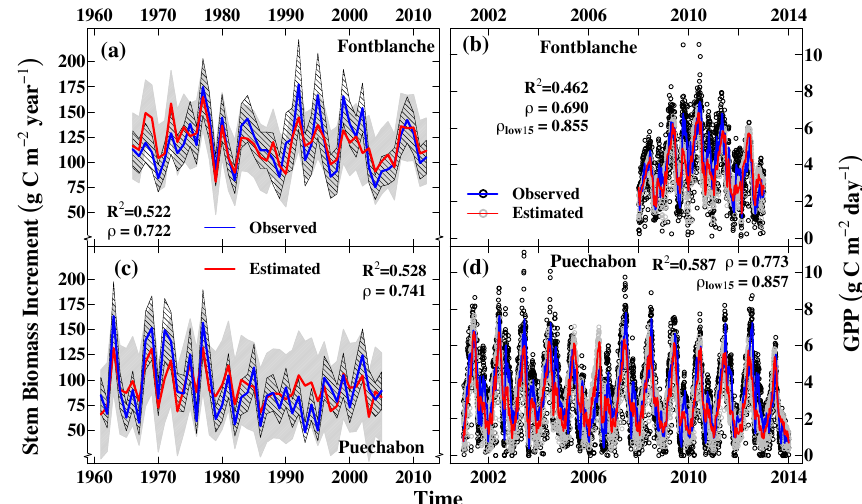
Figure 4. Model fit to stem biomass increment (a) and GPP (b) in Fontblanche and stem biomass increment (c) and GPP (d) in Puechabon. R 2 : coefficient of determination; ρ : linear correlation between estimated and observed data; ρ low15 : linear correlation between estimated and observed data smoothed with a 15-year low-pass filter (blue and red lines in b and c ). Polygons behind the estimated values in (a) and (c) correspond to confidence intervals of the mean: solid grey polygons for estimated values and dashed polygons for observed stem biomass increment values.